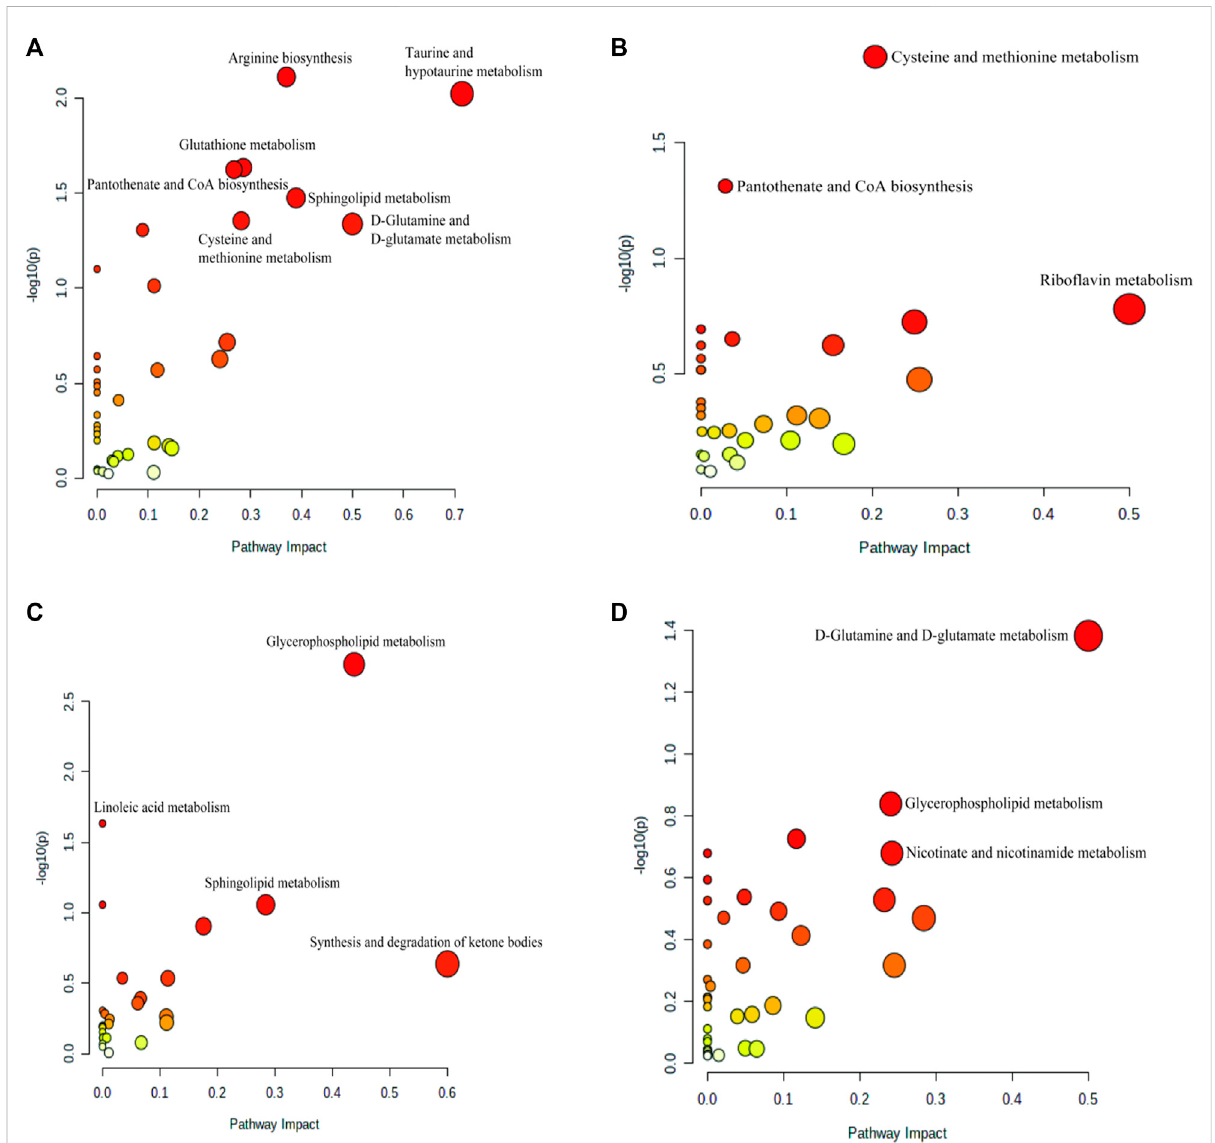
FIGURE 7 Enriched pathway analysis of the differential metabolites identi fi ed in the cerebral cortex (A,B) and the hippocampus (C,D) . (A,C) enriched metabolic pathways between the AD and sham groups; (B,D) the enriched metabolic pathways between the BSTSF and AD groups.